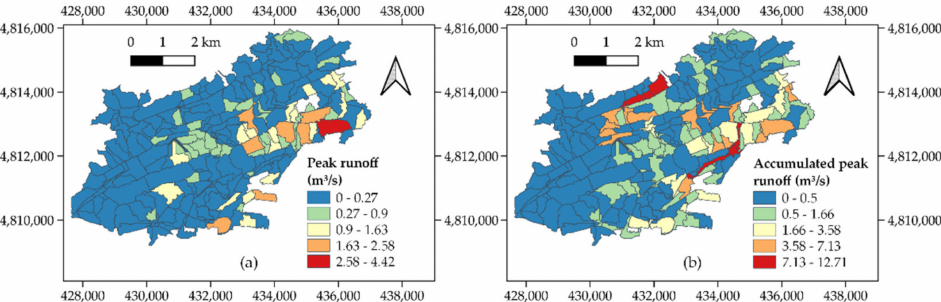
Figure 5. Values of ( a ) individual peak runoff (m 3 /s) and ( b ) accumulated peak runoff (m 3 /s) in the